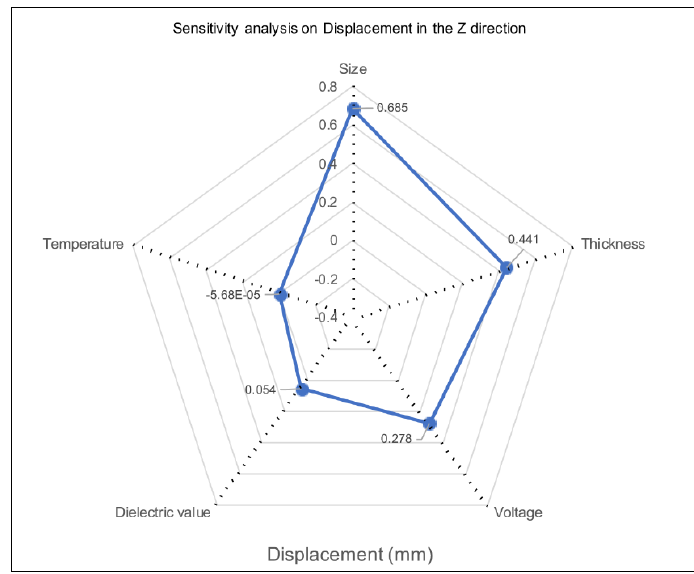
Figure 10. Finite Element Model Sensitivity Analysis.